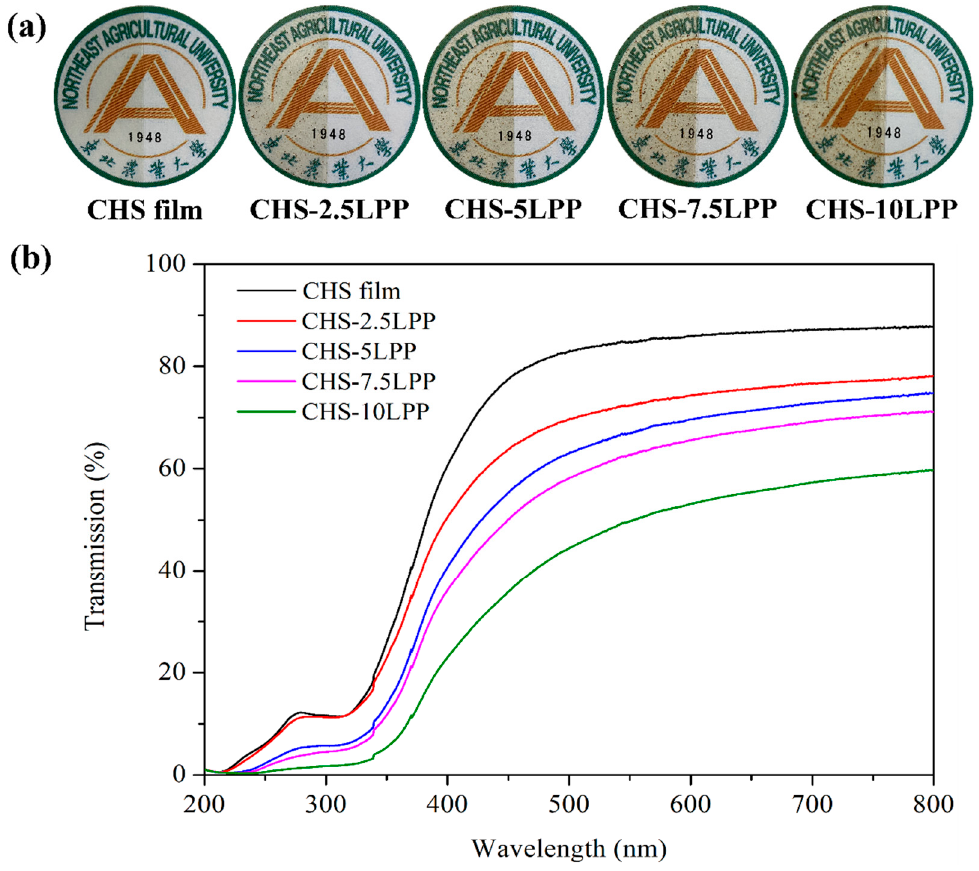
Figure 5. The physical appearance ( a ) and UV–vis light transmittance ( b ) of the films. Table 1. L , a , b , and Δ E of the films.